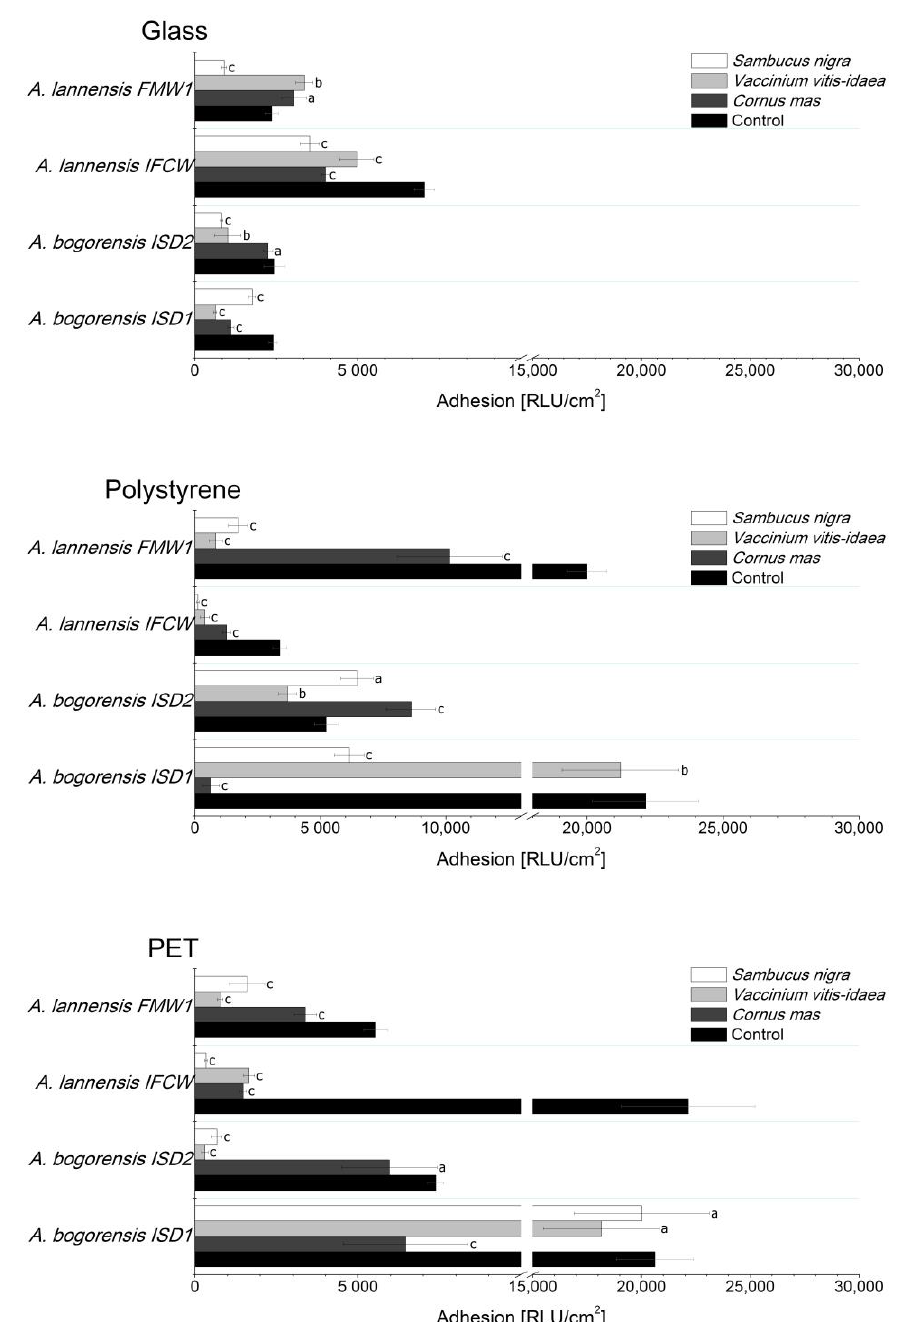
Figure 3. Adhesion of Asaia strains to glass, polystyrene and PET in minimal medium with addition of 10% elderberry, lingonberry and cornelian cherry. Results are expressed in relative light units (RLU)/cm 2 . Values are means of three determinations ± standard deviation. Values with the different letters are statistically different ( p < 0.05). a— p ≥ 0.05; b—0.005 < p < 0.05; c— p < 0.005; The results were compared to those received for a control